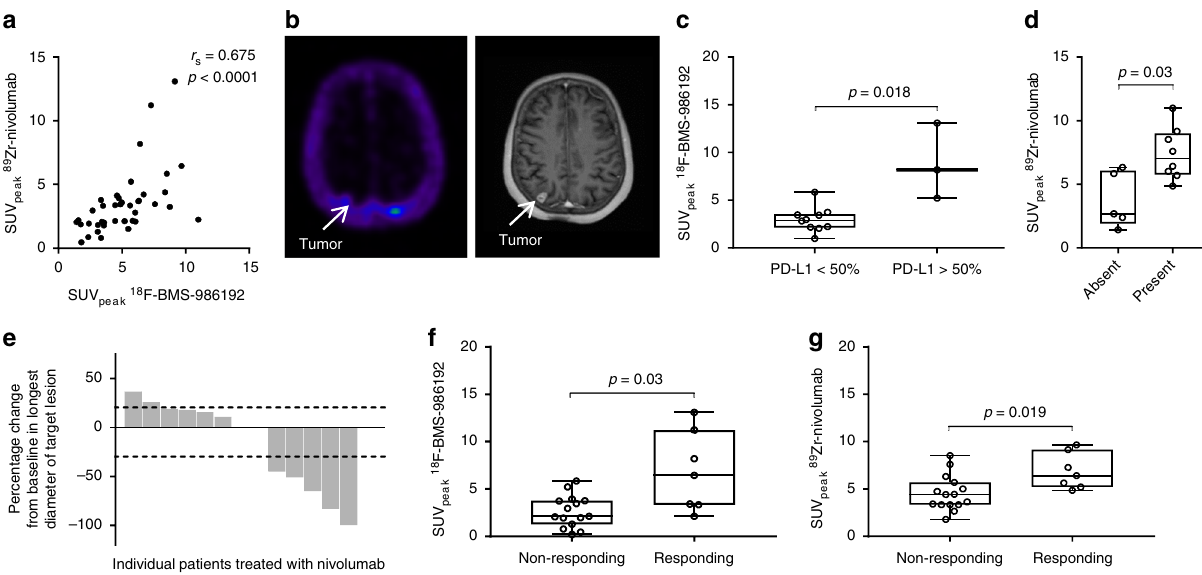
Fig. 2 Tracer uptake and correlation with immunohistochemical staining and response. a Correlation between SUV peak for 89 Zr-nivolumab and 18 F-BMS- 986192. R s = 0.68, p < 0.0001 as determined by the Spearman rank correlation. b Low uptake of the 18 F-BMS-986192 in an untreated brain metastasis in patient 4, due to PD-L1 expression heterogeneity or low CNS penetration of the tracer. c 18 F-BMS-986192 SUV peak is higher in patients with ≥ 50% tumor PD-L1 expression. p -value is 0.018, as determined by the Mann – Whitney U -test. d Lesions with no PD-1 expression in aggregates have a lower 89 Zr- nivolumab SUV peak . p -value is 0.03, as determined by the Mann – Whitney U -test. e Waterfall plot of the best objective response according to RECIST 1.1. f SUV peak of the 18 F-BMS-986192 tracer is higher in responding lesions as compared to non-responding lesions (comparison of lesions with diameter of 20 mm or more). p -value is 0.02, as determined by the Mann – Whitney U -test. g SUV peak of the 89 Zr-nivolumab tracer is numerically higher in responding lesions (comparison of lesions with diameter of 20 mm or more). p -value is 0.019, as determined by the Mann – Whitney U -test. For all the boxplots, the lower edge of the box represents the fi rst quartile and the upper edge represents the third quartile. The horizontal line inside the box indicates the median. Whiskers identify the minimum and the maximum